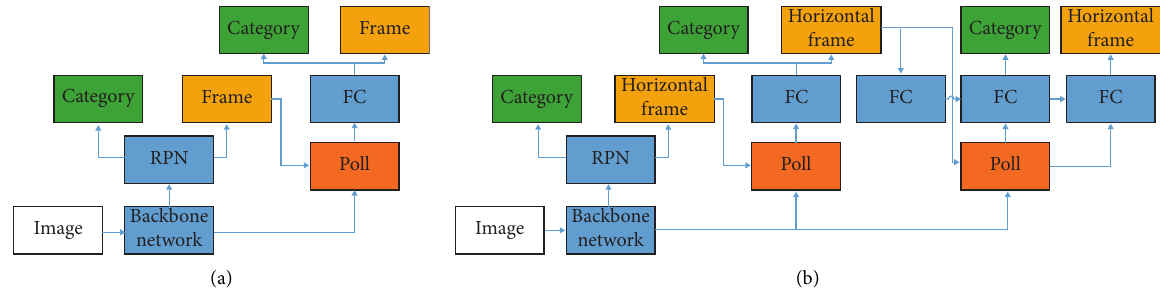
Figure 2: Comparison of general detection end and multidirectional multi-information detection end: (a) the general detection end; (b) the multidirection and multi-information detection end.